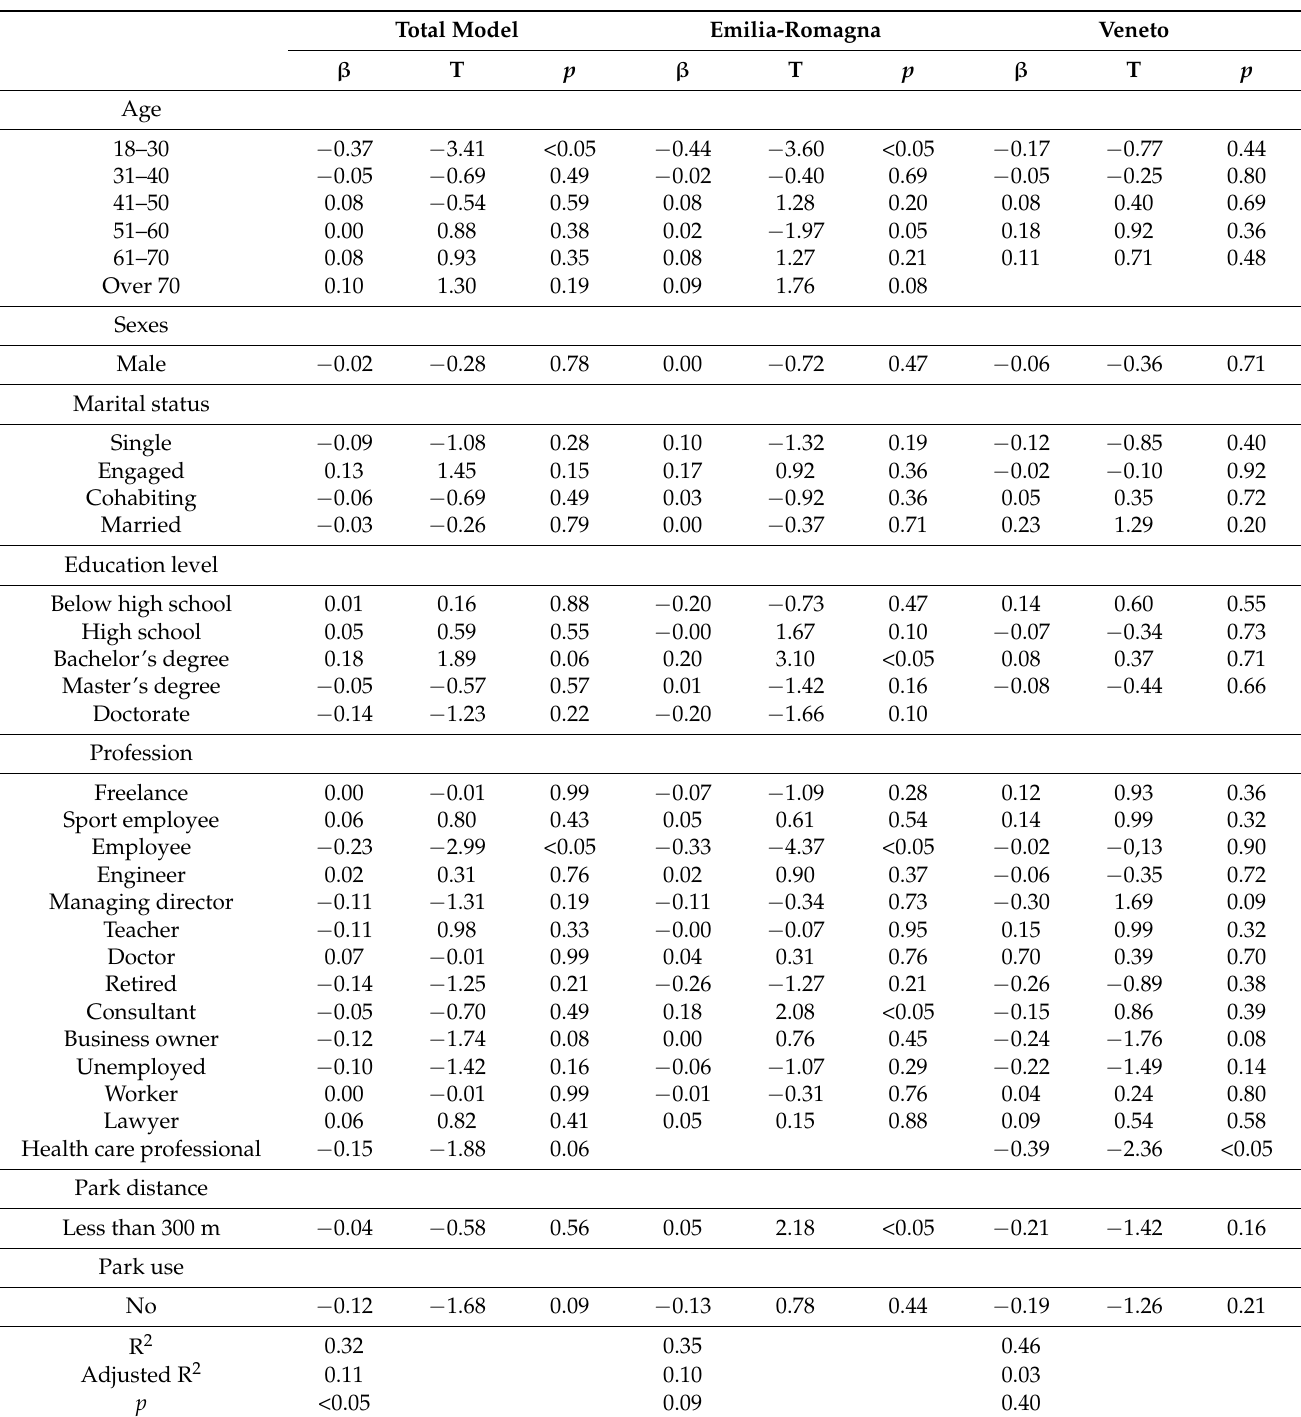
Table 8. Multiple regression for the affective component.